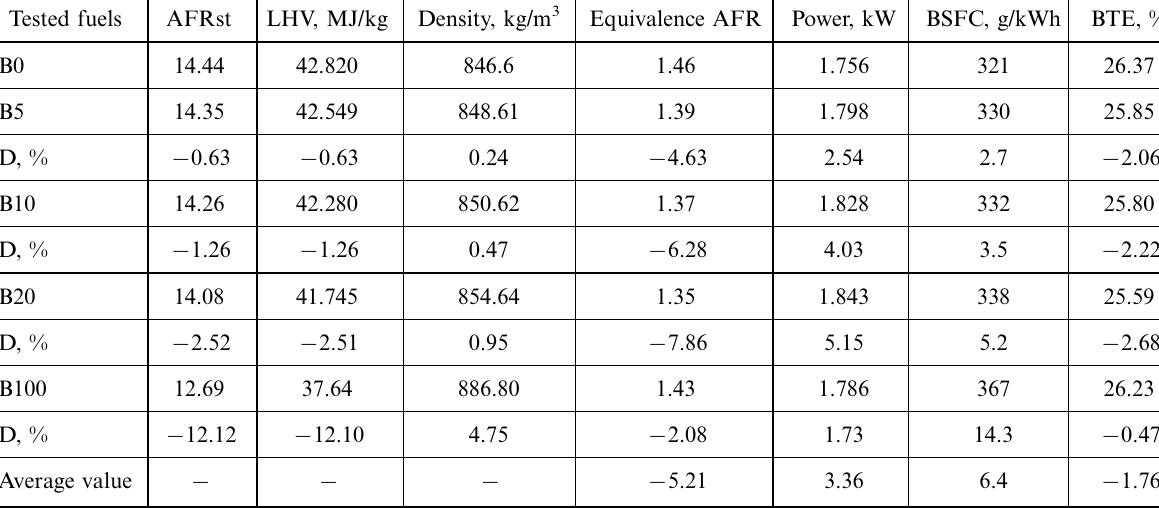
Table 4. The deviations of the biodiesel and fuel blends as compared with diesel fuel based on an average values Tested fuels AFRst LHV, MJ/kg Density, kg/m